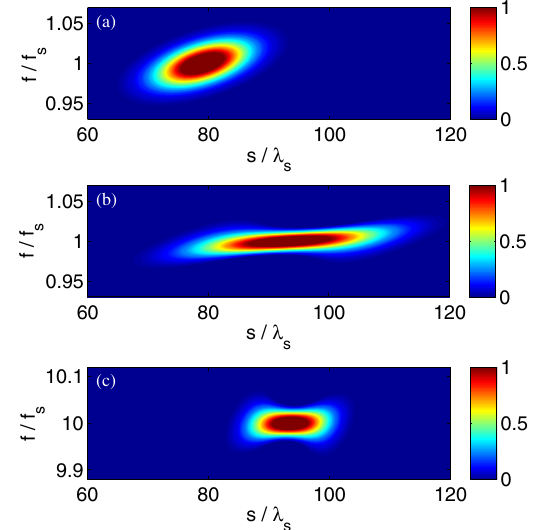
FIG. 5. Wigner distributions of the seed laser with FWHM pulse length of 17 (cid:1) s (a) and local bunching factor at fundamen- tal (b) and 10th harmonic (c) of the seed. The frequency chirp in the seed laser pulse is (cid:6) ¼ 0 : 006 =(cid:1) s 2 .